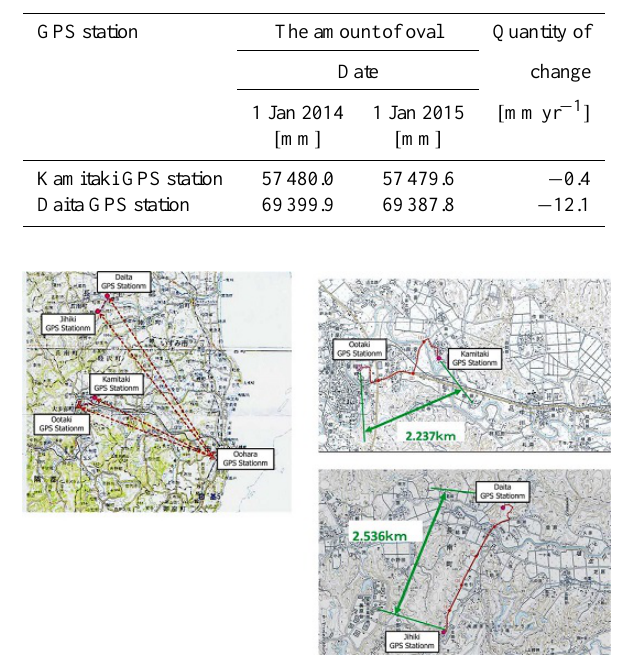
Table 3. GPS observation result.